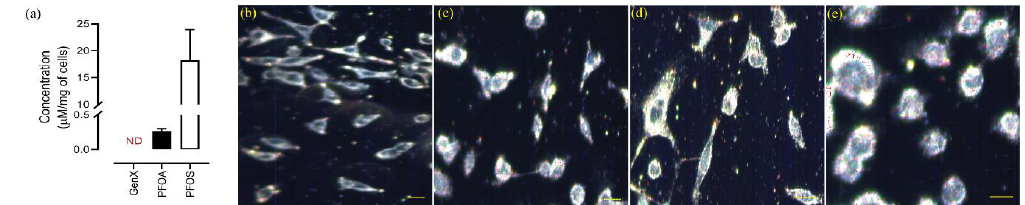
Figure 6. Intracellular levels of PFASs using UPLC-MS, and imaging of cells with Hyperspectral dark-field microscopy (HS-DFM) imaging. ( a ) The PFOS has the highest potential to accumulate inside A549 cells, the GenX was not detected. The data are given as the mean ± S.D. for three independent experiments. ND—not detected. (n = 3) ( b ) Hyperspectral images of A549 cells for control and ( c – e ) exposed to GenX, PFOA and PFOS, respectively. The red dots inside the cells denote the compound taken up by the cell, identified by Spectral angular mapping. Scale bar: 10 μm.